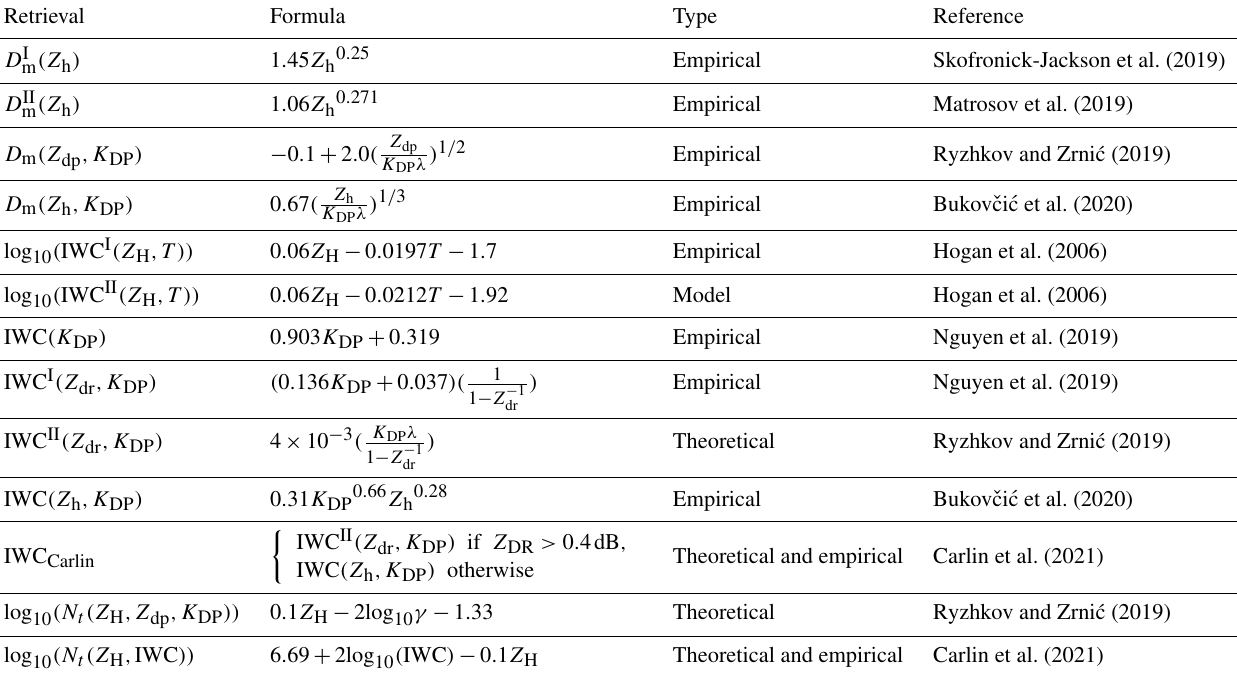
Table 2. Table of retrieval equations used in this work ( D m is in units of mm, IWC is in units of gm − 3 , and N t is in units of L − 1 ; T is in units of ◦